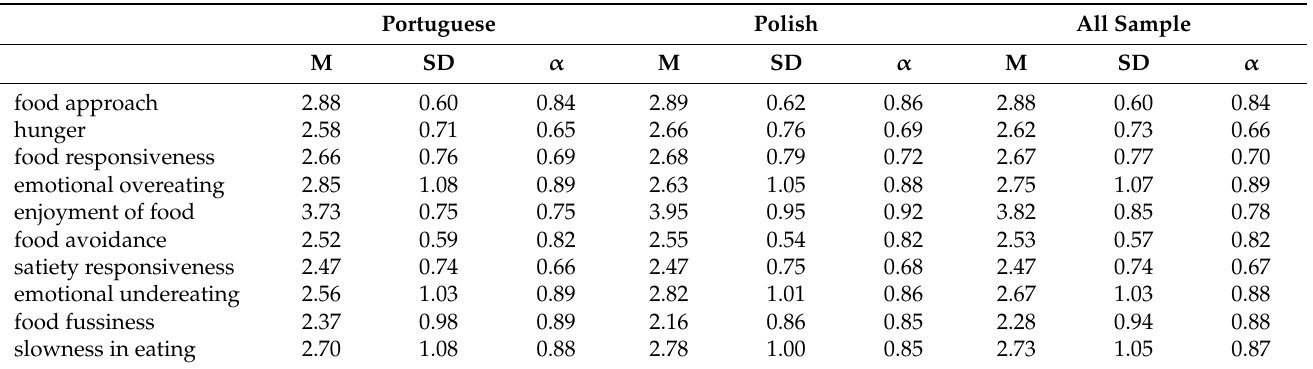
Table 7. Descriptive statistics for the dimensions of the AEBQ questionnaire, along with Cronbach’s alpha statistics in each group.